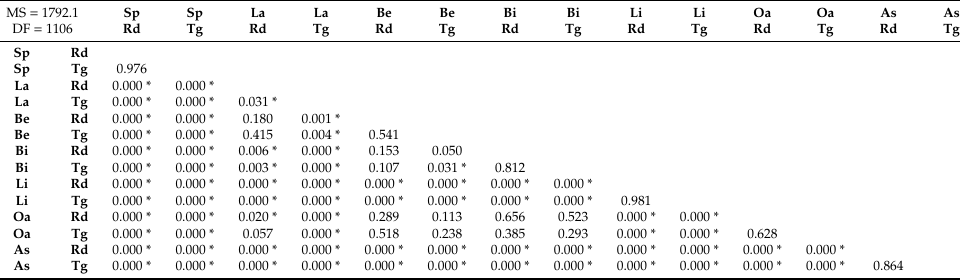
* Values are significant at p < 0.05. Error: between MS = mean squares, DF = degrees of freedom. Wood Species: Sp = Spruce; La = Larch; Be = Beech; Bi = Birch; Li = Linden; Oa = Oak; As = Ash. Load Direction: Rd = Radial; Tg =